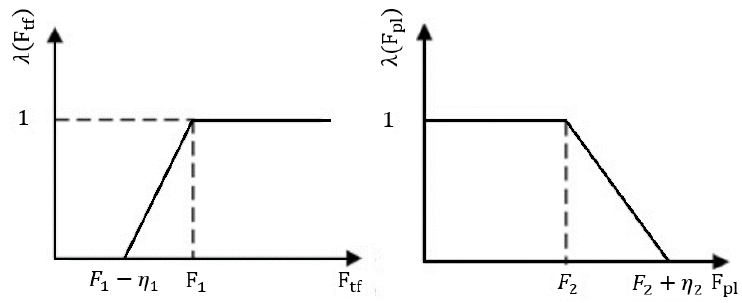
Figure 5. Membership function.